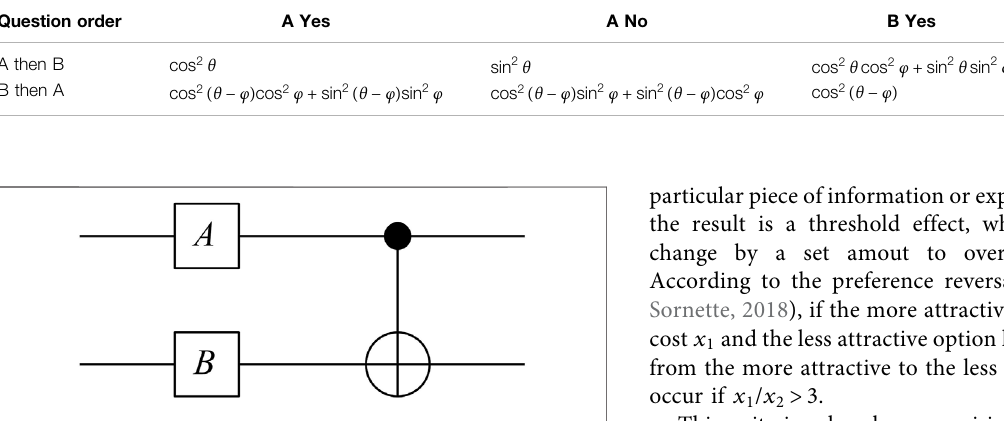
FIGURE 3 | Quantum circuit for a decision B in fl uenced by a context A .